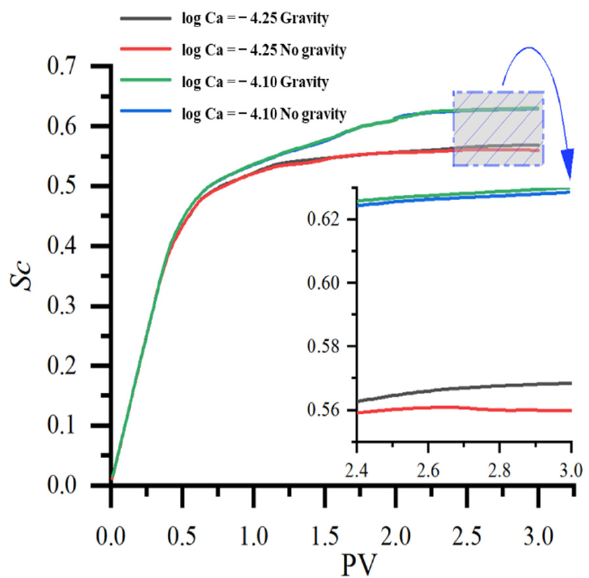
Figure 15. Influence of gravity on final CO 2 saturation ( Sc ) after CO 2 flooding.